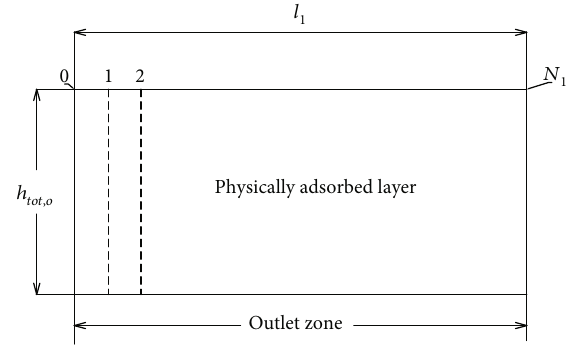
Figure 3: The discretized points in the outlet zone.